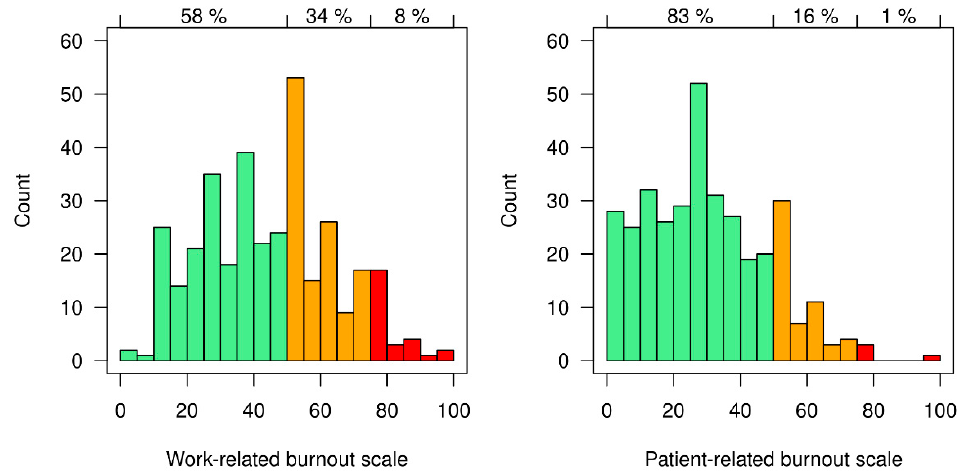
Figure 1. Data on the Copenhagen Burnout Inventory (CBI) scales for work-related and patient- related burnout risk (Green = low; orange = moderate; red = high).